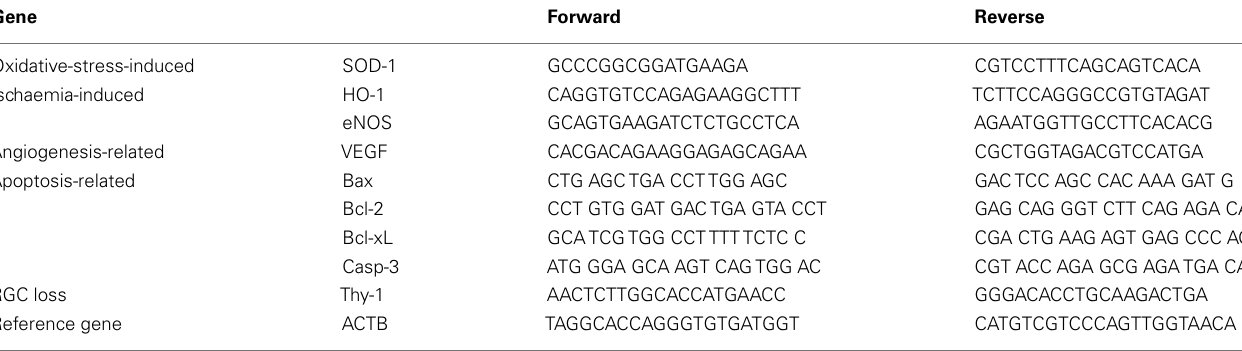
Table 1 | Primer sequences used for RT-PCR